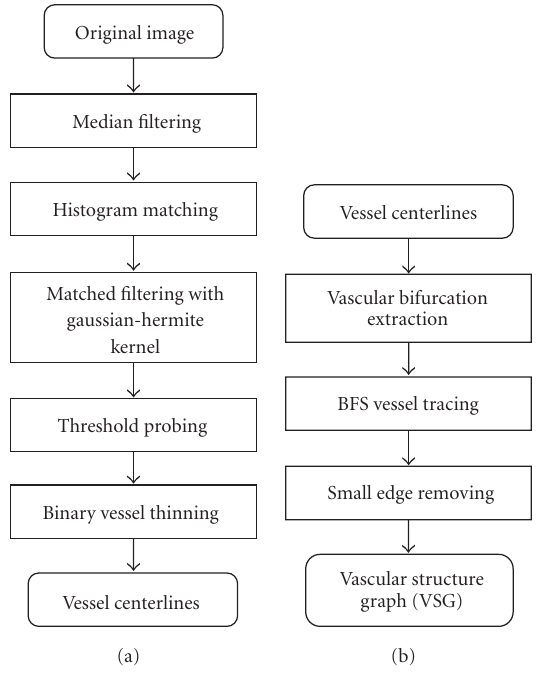
Figure 2: Flowchart of retinal feature extraction method described in this paper. (a) The process of vessel centerline detection. (b) The process of VSG